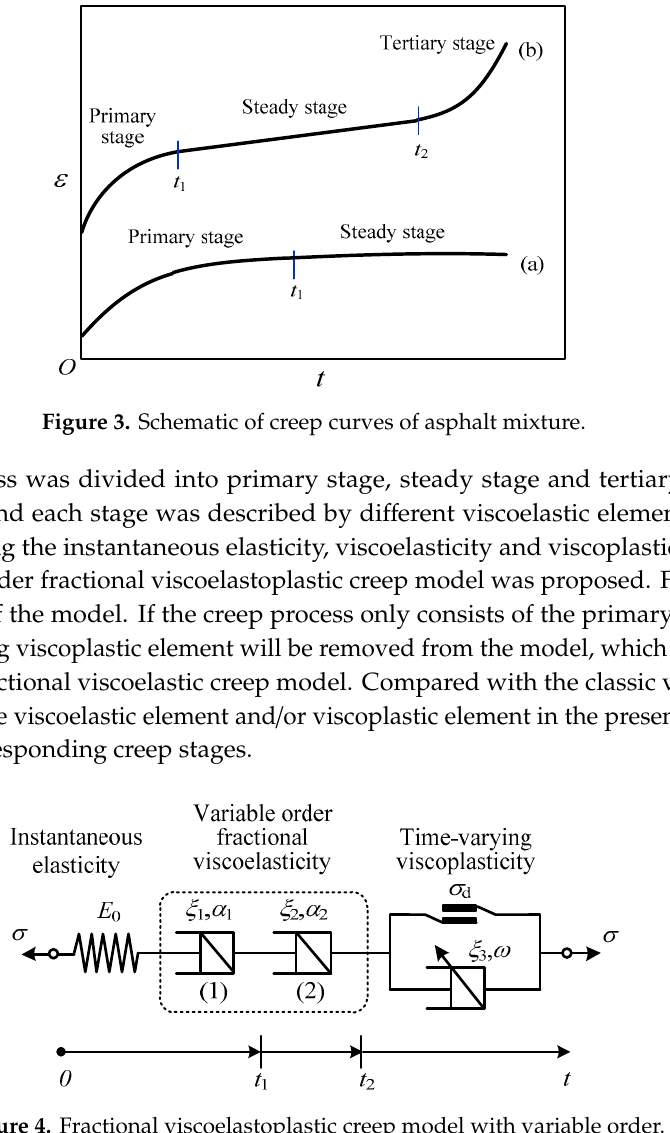
Figure 3. Schematic of creep curves of asphalt mixture.